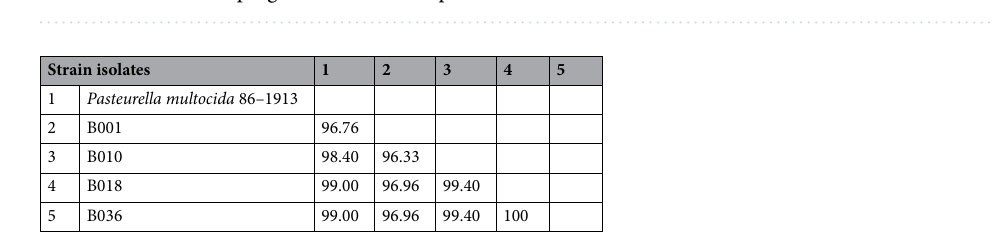
Figure 5. Results of the Pasteurella multocida isolate selection test to be used in purification of protein sialidase. ( A ) Phylogenetic tree showing the relationship between Pasteurella multocida isolates; ( B ) Alignment of amino acids with the Bioedit program to determine points of difference in amino acids.